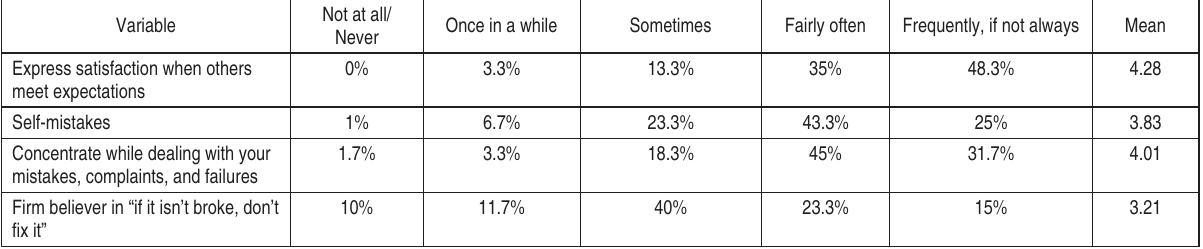
Table 3. Transactional leadership styles of the